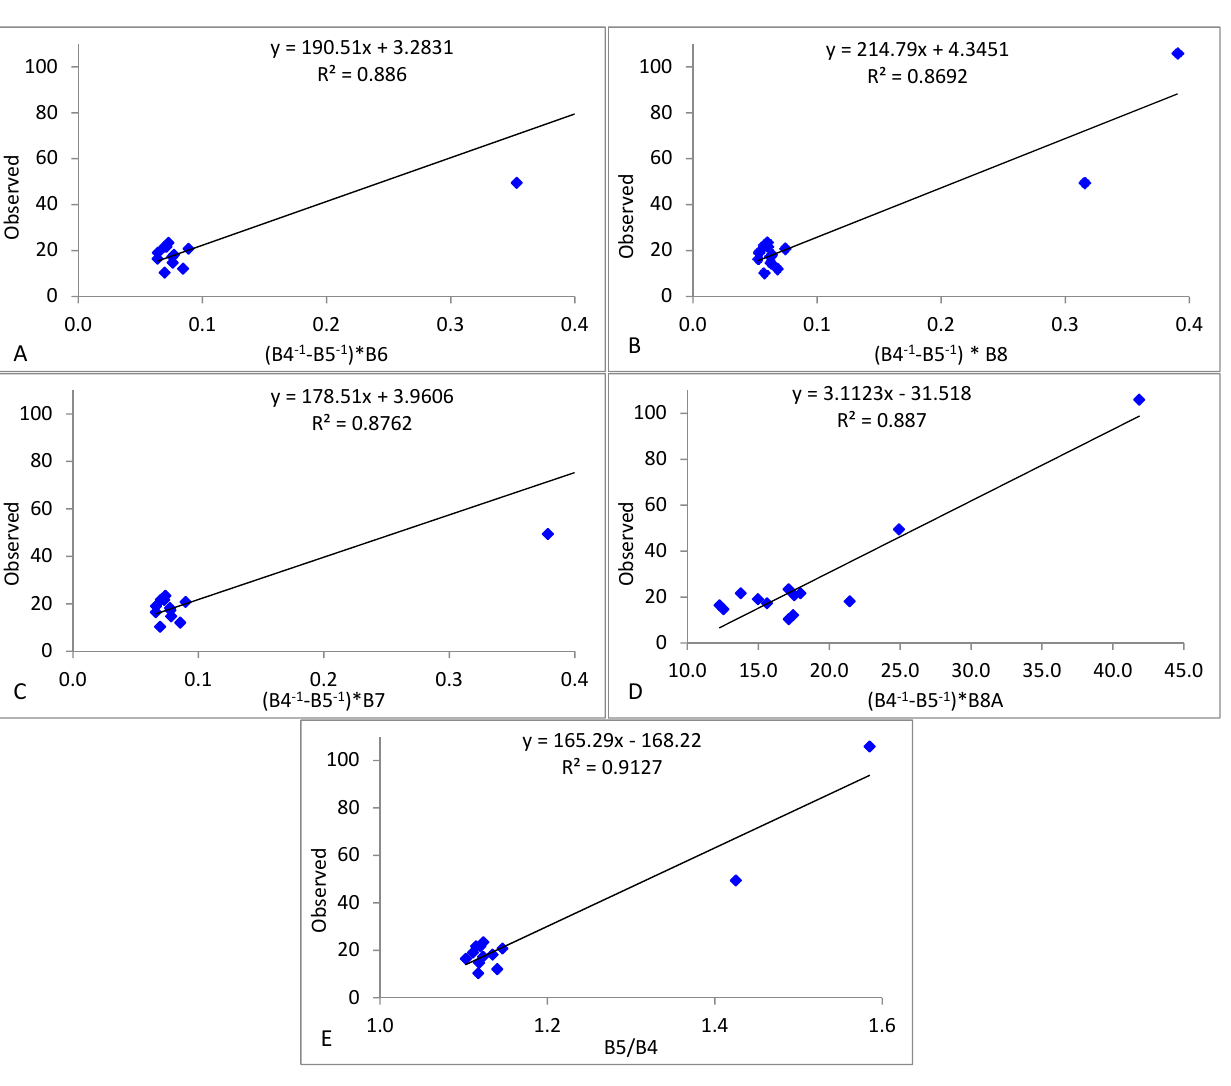
combinations (ratio) B5/B4, (1/B4 − 1/B5) ∗ B8A, (1/B4 − 1/B5) ∗ B7, (1/B4 − 1/B5) ∗ B6, and (1/B4 − 1/B5) ∗ B8 equals to 0.34, 0.11, 0.60, 0.53, and 0.55, respectively, corresponding to 5